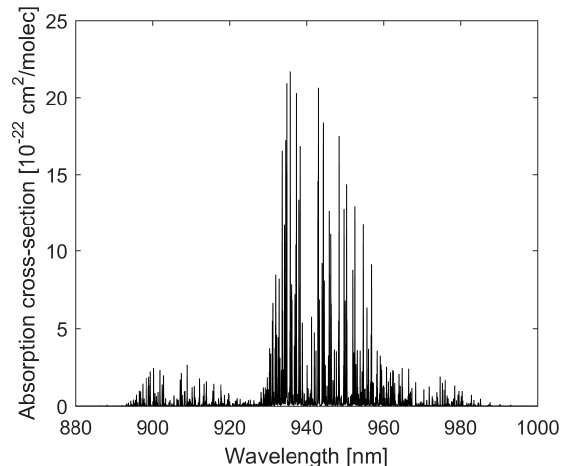
Figure 1. Absorption cross-section of water vapor between 880 and 1000 nm. Line strength data is from the HITRAN2012 database [11].